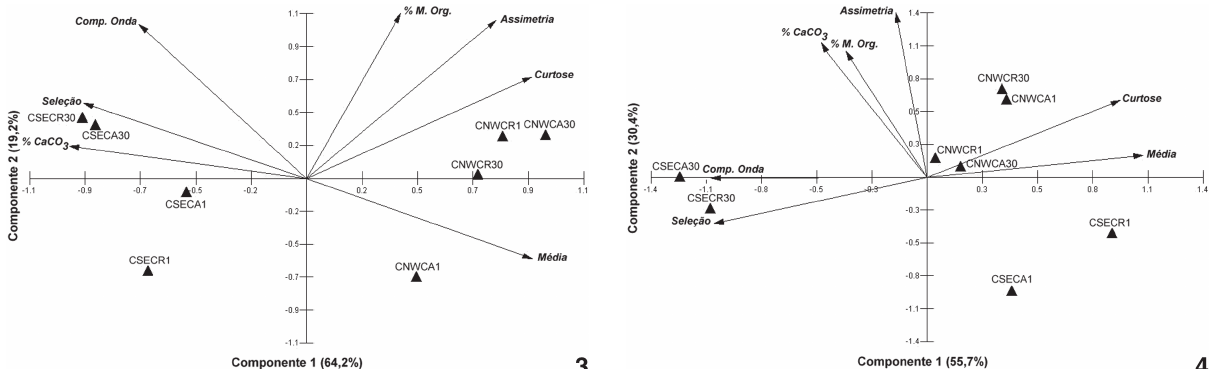
Figuras 3-4. Resultados da análise de Componentes Principais dos parâmetros sedimentológicos da ilha Currais (C) no verão (2) e no inverno (4); na face exposta (SE) e face protegida (NW); nas cristas (CR) e cavas (CA); nos distanciamentos de 1 e 30 m.